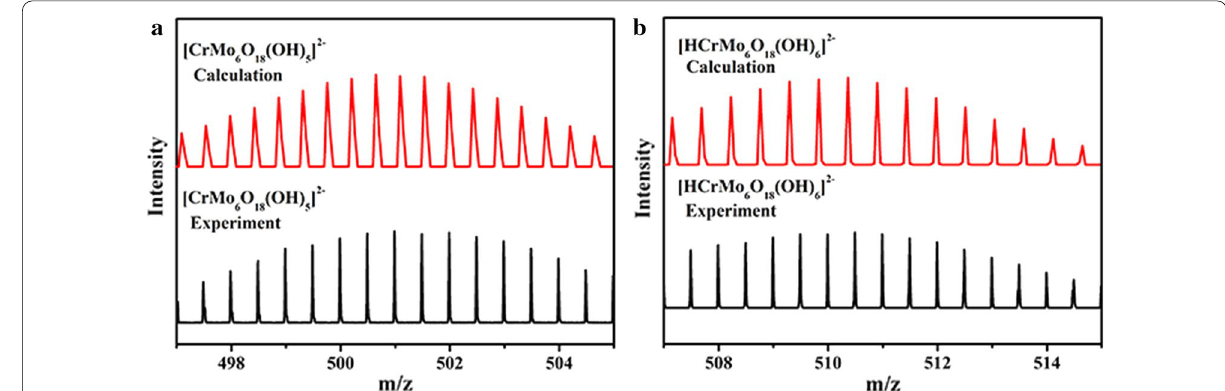
Fig. 13 Negative mode ESI-MS spectra of EuCrMo 6 microflakes in distilled water in the range of 865–887 m/z